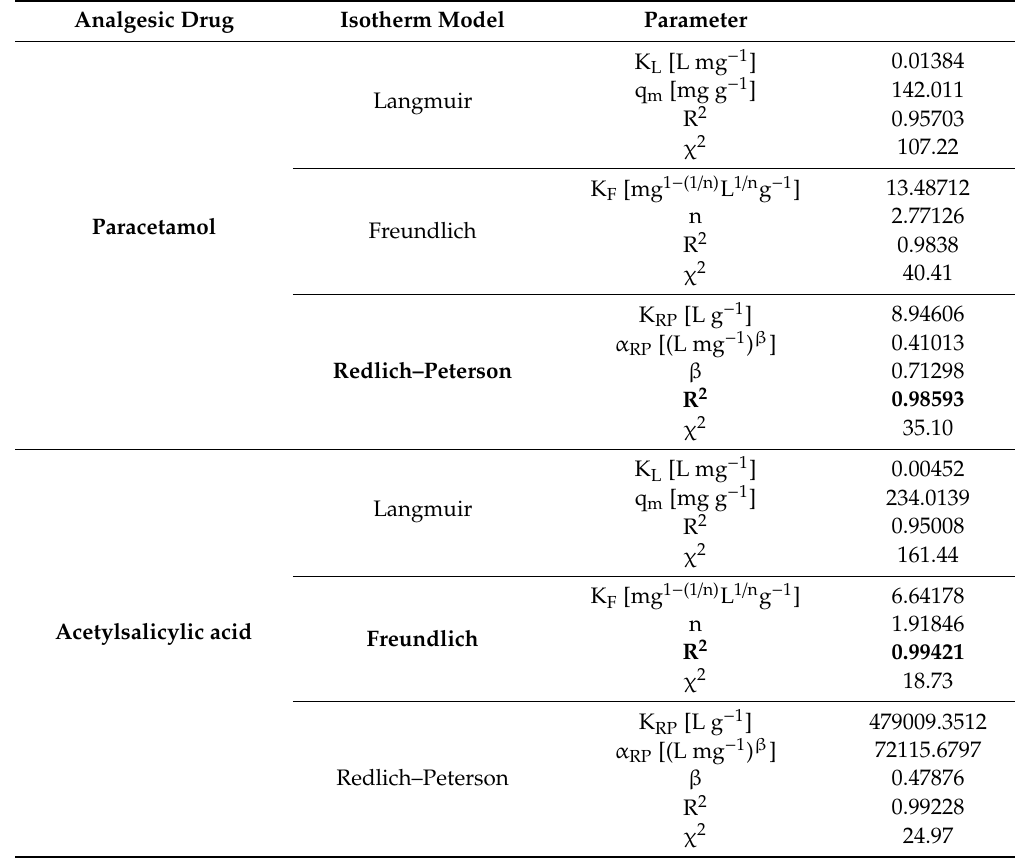
Table 3. Isothermal parameters and correlation coe ffi cients for paracetamol and acetylsalicylic acid adsorption, respectively, on 2 g / L mass of Fe 3 O 4 @C